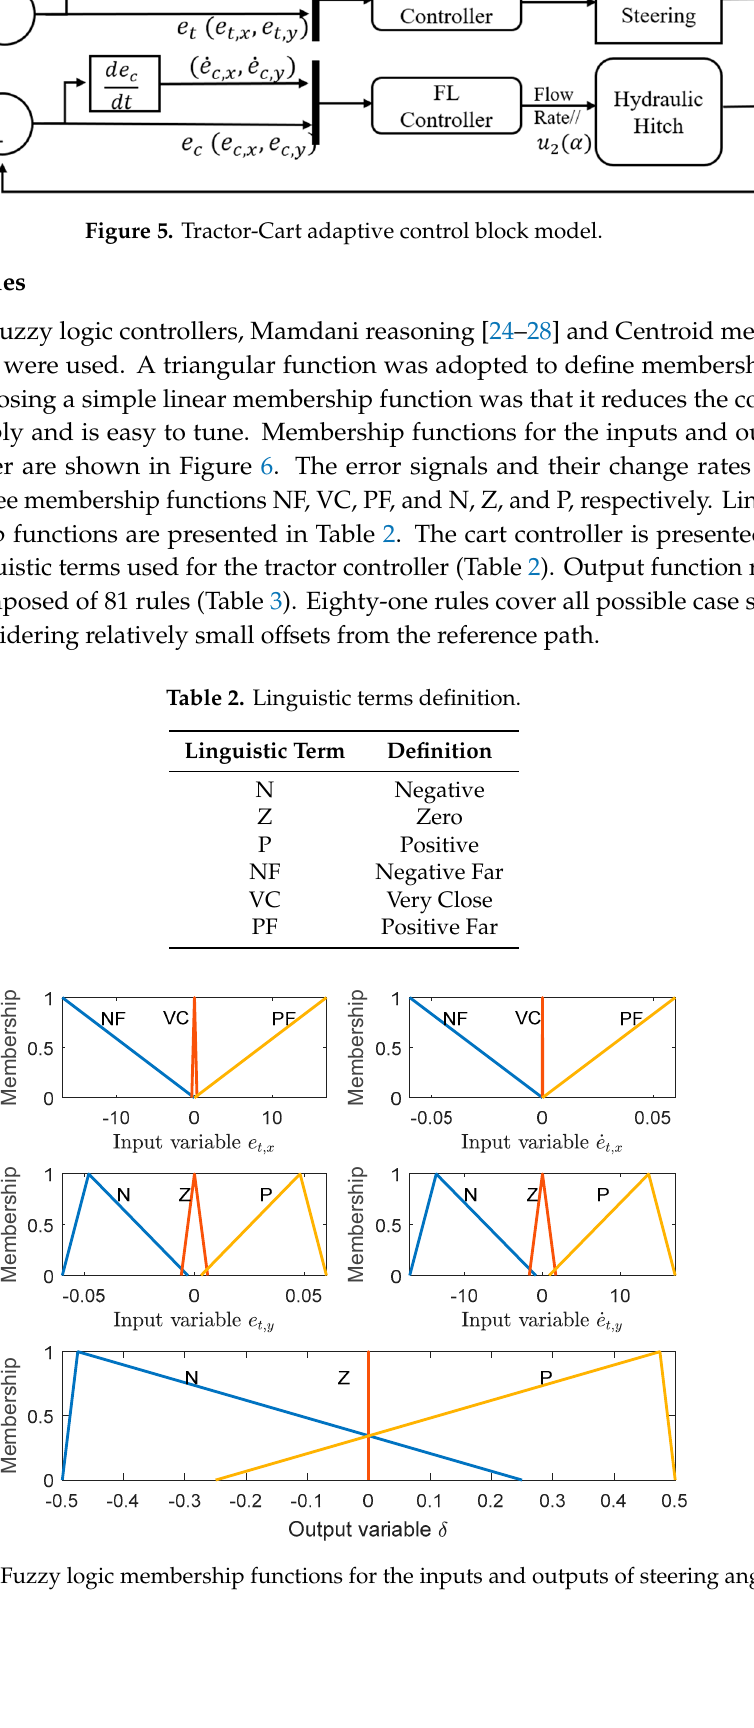
Figure 7 . Membership functions of the input and output variables of the cart controller . Table 3. Fuzzy logic controllers . / y